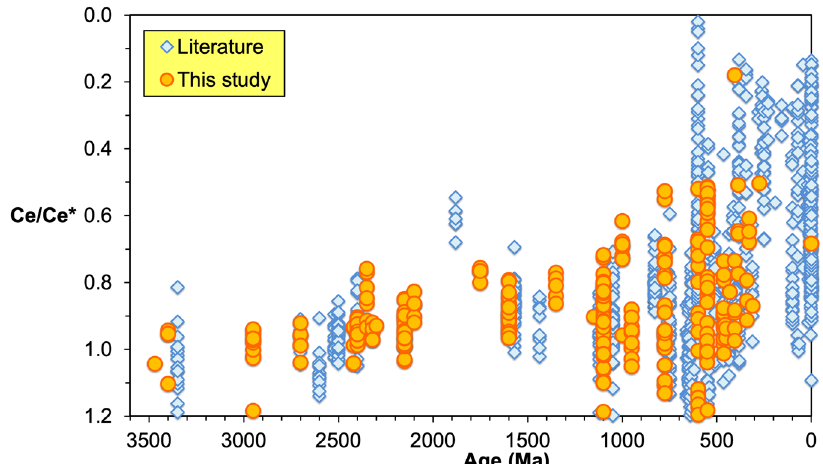
Fig. 1 Secular trend of Ce anomaly (Ce/Ce*) in marine carbonates. The fi gure contains >1300 data points for Ce anomaly, including literature data (blue diamonds) and our 305 new analyses